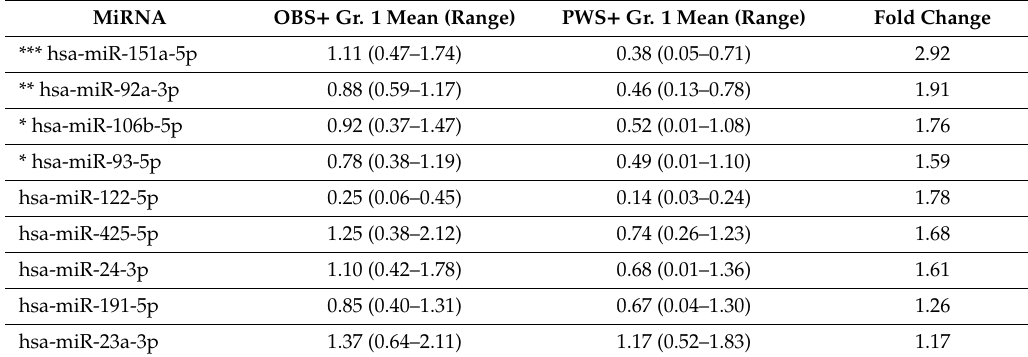
Table 2. Relative mean ∆∆ Cq expression of serum miRNAs of grade 1 PWS + subjects and OBS + subjects. MiRNA